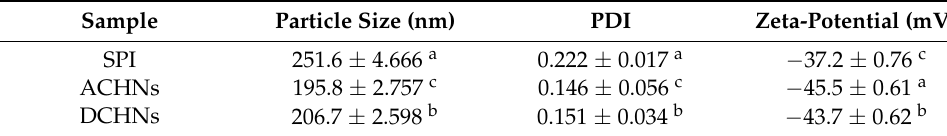
Table 3. Particle size and zeta-potential of modified soybean protein emulsion.